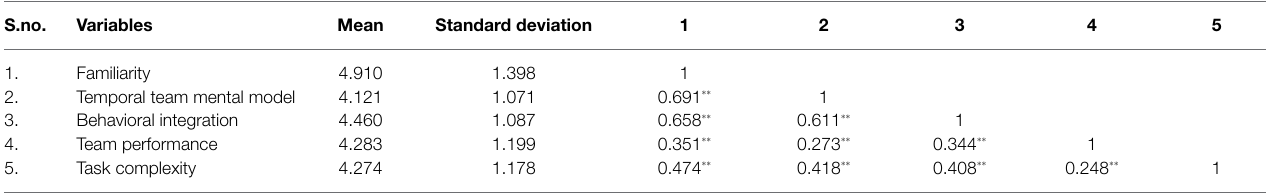
TABLE 2 | Correlation